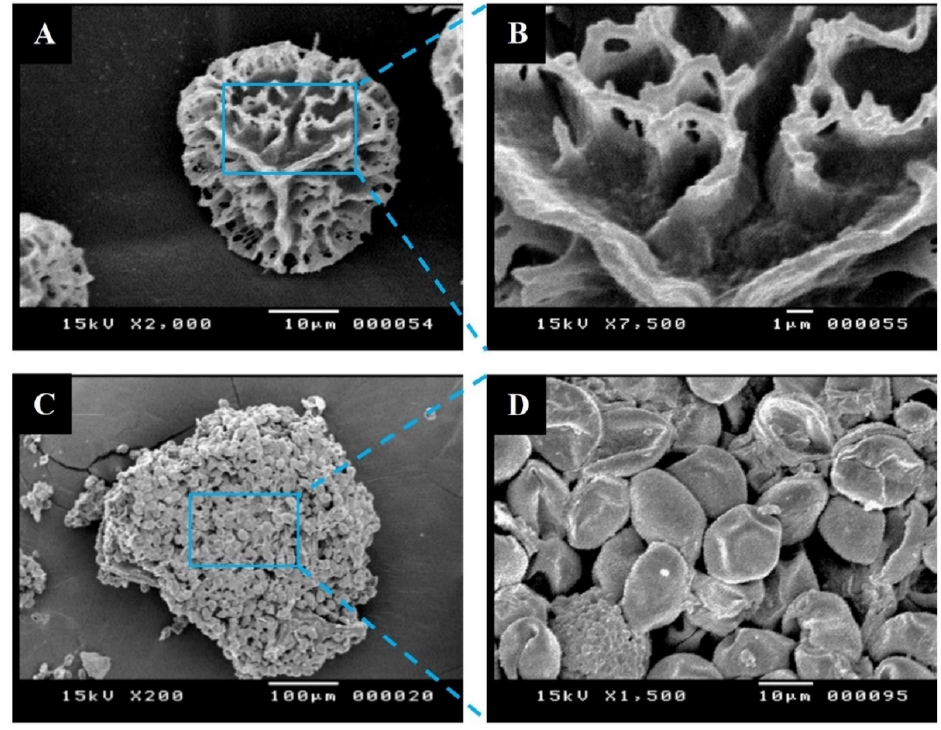
Figure 4. SEM images of microcapsules after MTF loading at different magnifications showing surface morphology. ( A , B ) MTF-Loaded LCS and ( C , D ) MTF-loaded DPP.